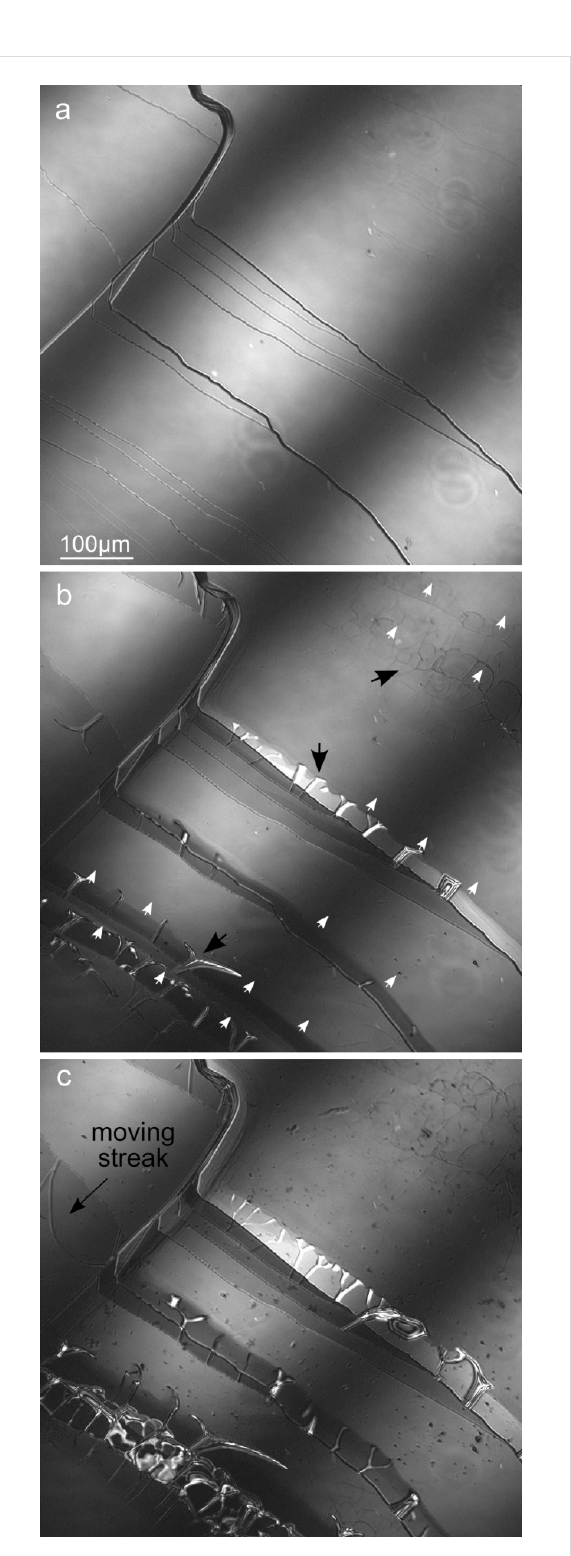
Figure 3: LCM-DIM images: a) freshly cleaved biotite (001) surface; b) same surface after about 33 h and c) after about 51 h at pH 9.5 and 50 °C. White arrows and black arrows in b) indicate edge retreat and streaks, respectively. Streaks formed (b) and grew (c) from steps